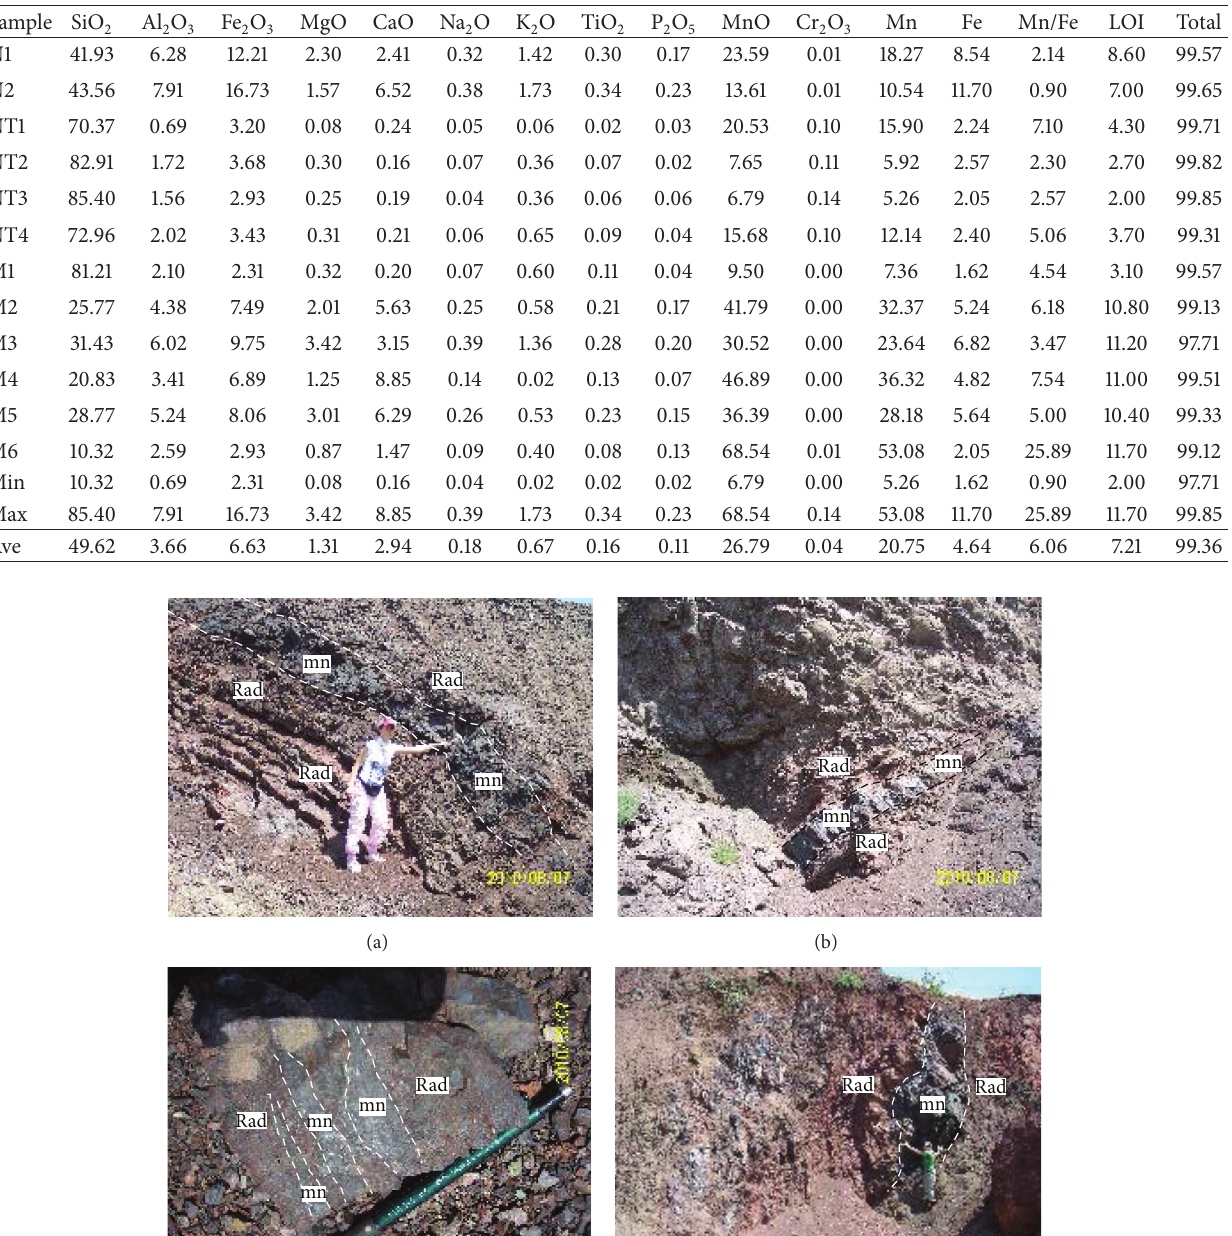
Table 1: Major oxide contents of Buyukmahal ore (%).